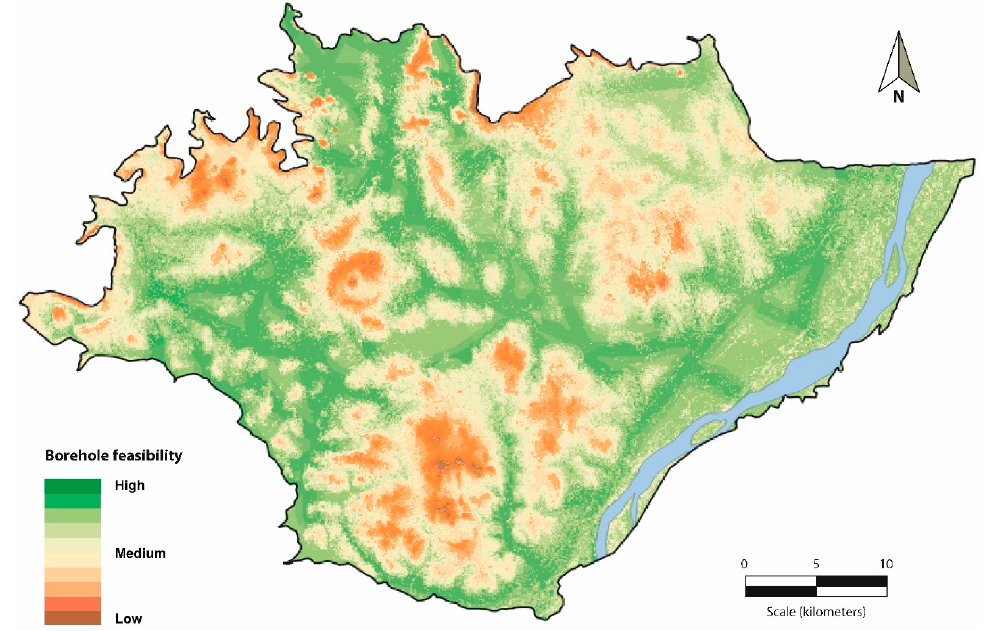
Figure 11. Drilling feasibility map.